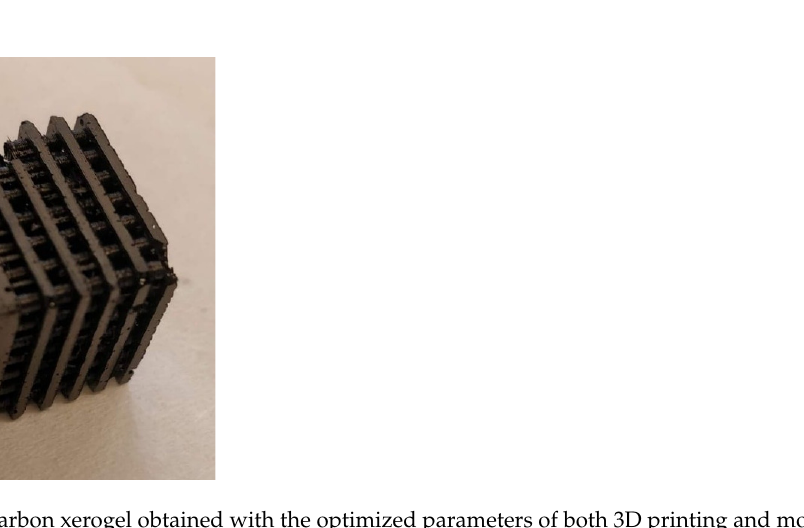
Figure 5. Best carbon xerogel obtained with the optimized parameters of both 3D printing and mold removal by solvent